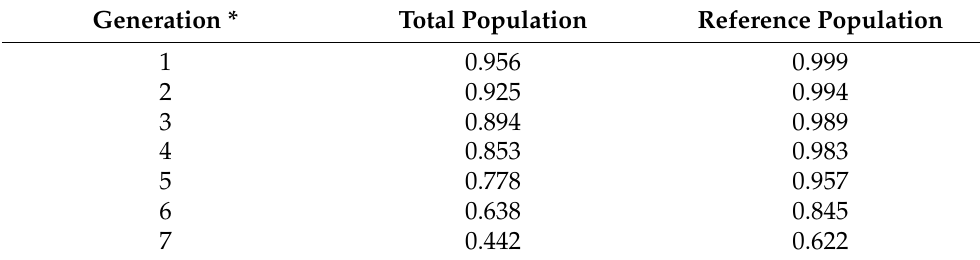
Table 2. Percentages of pedigree completeness in the total and the reference populations at various generations.